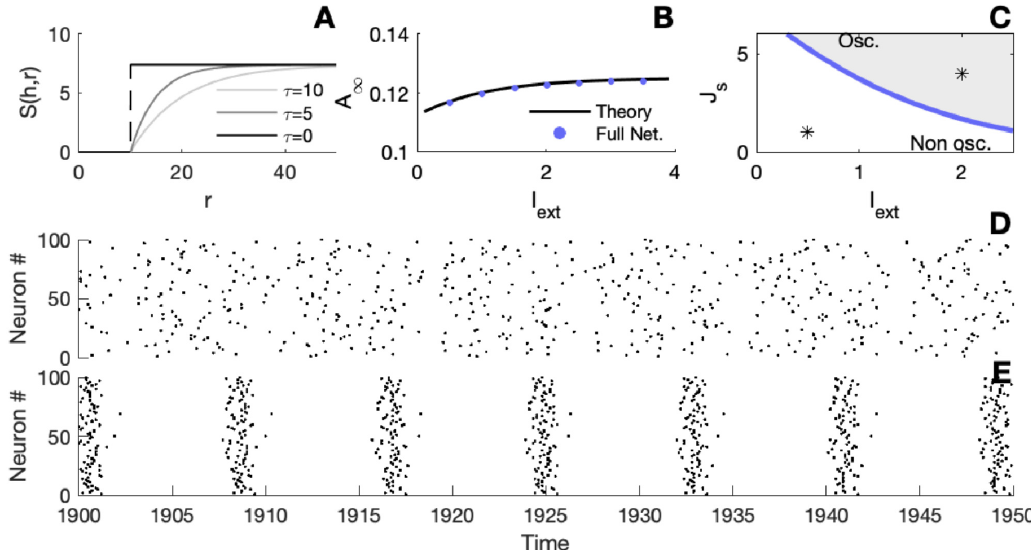
Fig 2. Emergent oscillations. A) Illustration of the escape rate S ( h , r ) for different values of the parameter τ , ( h = 2 mV ). B) Comparison between the steady state firing activities with J s = 1 mV . ms , blue dots for the full network, and the black line for the theoretical prediction given by (4). C) Bifurcation line in the parameter space (blue curve). The grey shaded region corresponds to an oscillatory regime of the neural network, the white region corresponds to a stable asynchronous mode of the network. D) and E) Raster plots of the spiking activity of 100 neurons. Panel D corresponds to the black asterisk lying in the asynchronous (white) region of panel C, whereas panel E depicts the activity that corresponds to the black asterisk lying in the oscillatory (grey) region of panel C. parameters: S ( h , r ) = exp( h ) H ( r − T ) (1 − exp( − ( r − T ) / τ )), T = 8 ms , τ = 10 ms , τ = 0 ms , N = 5000 and Δ t = 0.1 ms ref ref ref s